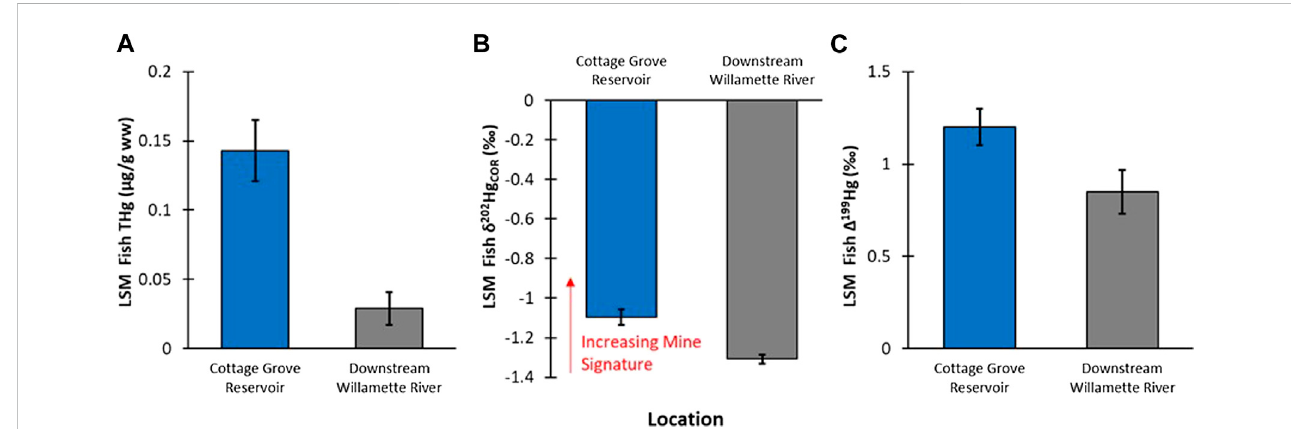
FIGURE 2 (A) : Comparison of least square mean (LSM ± standard error — SE) of YOY Largemouth Bass fi sh tissue THg concentrations between Cottage Grove Resevoir ( n = 14) and downstream sample locations in Willamette River ( n = 38; fi sh length was a sign fi cant covariate in the GLM analysis). (B) : Comparison of LSM ±SE of YOY fi sh tissue δ 202 Hg compositions between Cottage Grove Resevoir and downstream sample locations in Willamette River ( fi sh species was a signi fi cant covariate in the GLM analysis). (C) : Comparison of LSM ±SE of YOY fi sh tissue Δ 199 Hg compositions between Cottage Grove Reservoir and downstream sample locations in Willamette River ( fi sh species was a signi fi cant covariate in the GLM analysis).